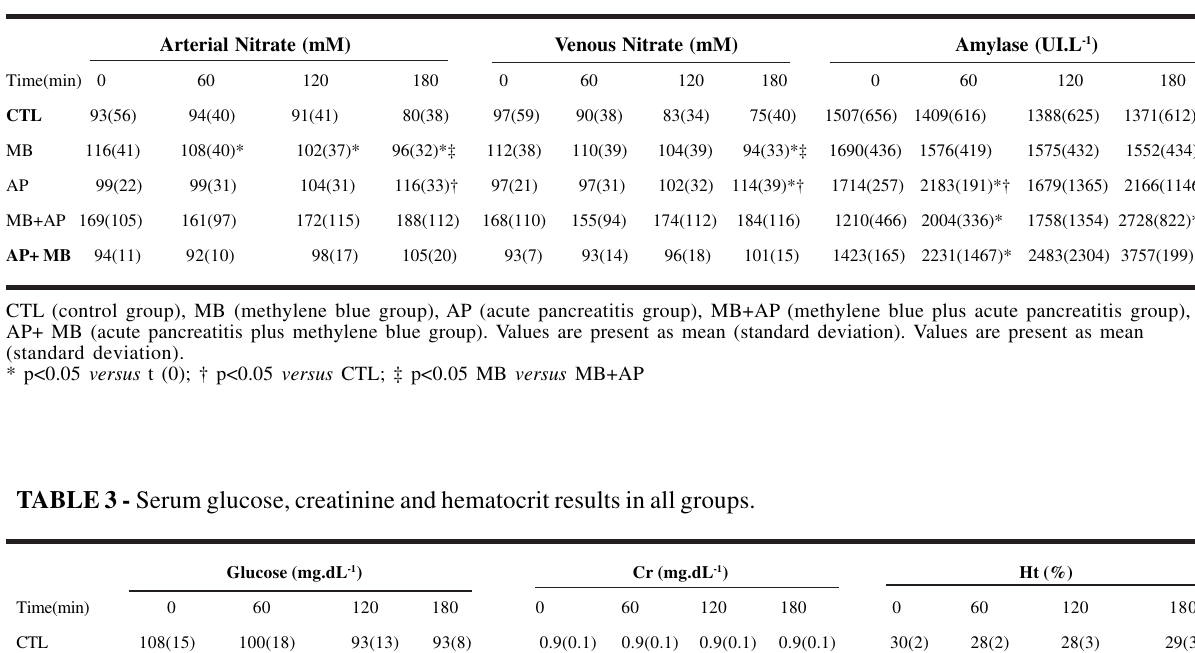
FIGURE 2 - Malondialdehyde (MDA) relative variation in all groups. CTL (control group), MB (methylene blue group), AP (acute pancreatitis group), MB (methylene blue group), MB+AP (methylene blue plus acute pancreatitis group), AP+ MB (acute pancreatitis plus methylene blue group). * p<0.05 versus t (0); † p<0.05 CTL versus AP; ‡ p<0.05 AP versus AP+MB; # p<0.05